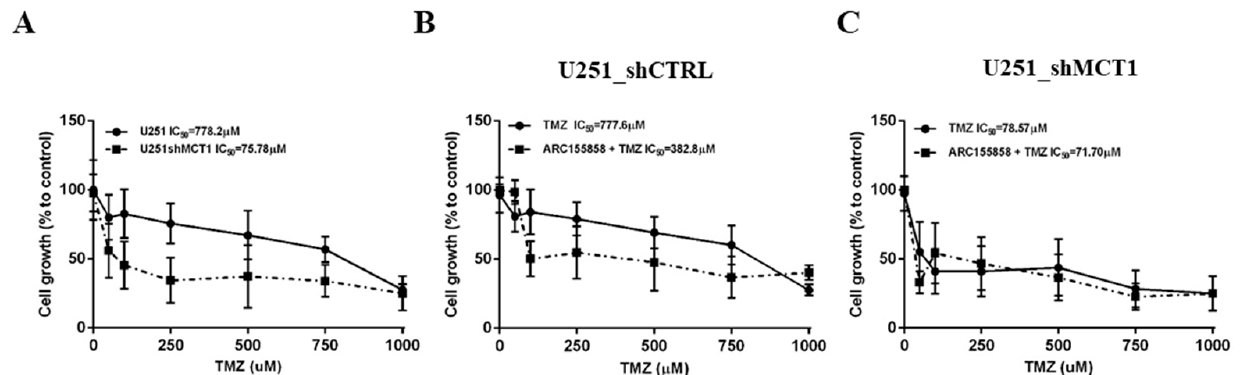
Figure 4. MCT1 inhibition effect on glioma cells TMZ response. ( A ) Response to TMZ in U251 shCTRL and U251 shMCT1; Effect of 300 nM AR-C155858 in TMZ response for U251 shCTRL ( B ) and U251 shMCT1 ( C ). IC50 values mean are representative of three independent experiments.